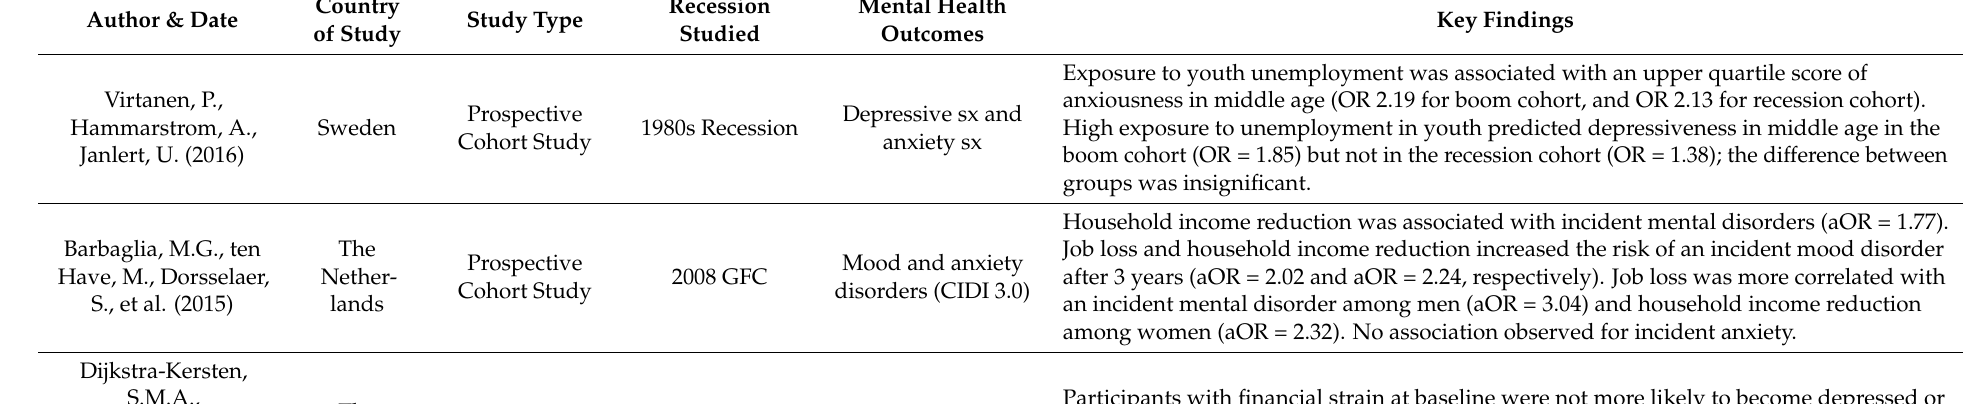
Table 2. Summary of included articles on depression, anxiety, and post-traumatic stress disorder (N = 36). Key Findings Exposure to youth unemployment was associated with an upper quartile score of anxiousness in middle age (OR 2.19 for boom cohort, and OR 2.13 for recession cohort). High exposure to unemployment in youth predicted depressiveness in middle age in the boom cohort (OR = 1.85) but not in the recession cohort (OR = 1.38); the difference between groups was